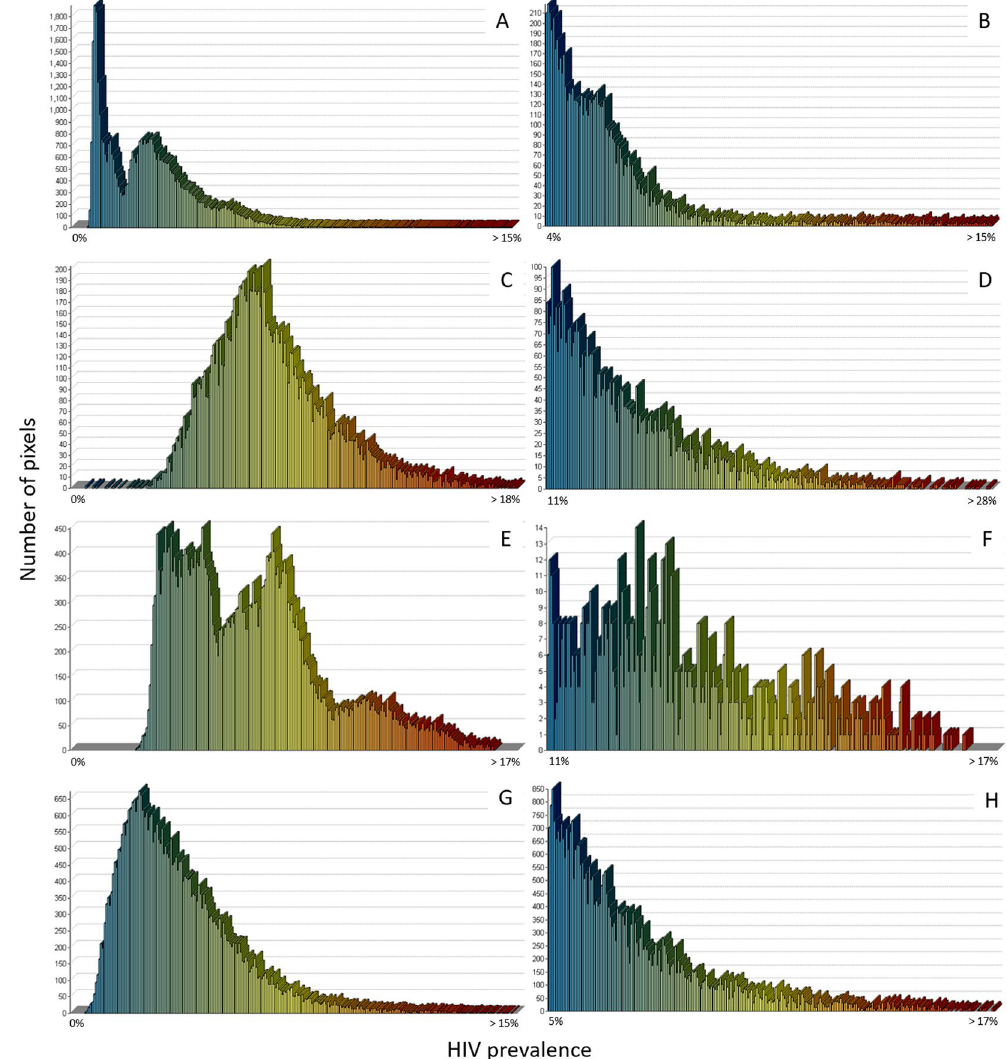
Figure 4. Density distribution of HIV prevalence in Kenya, Malawi, Mozambique and Tanzania for the entire country (left panel; A, C, E, G) and areas with high HIV prevalence ( ≥ 80 th percentile) in the same country (right panel; B, D, F,